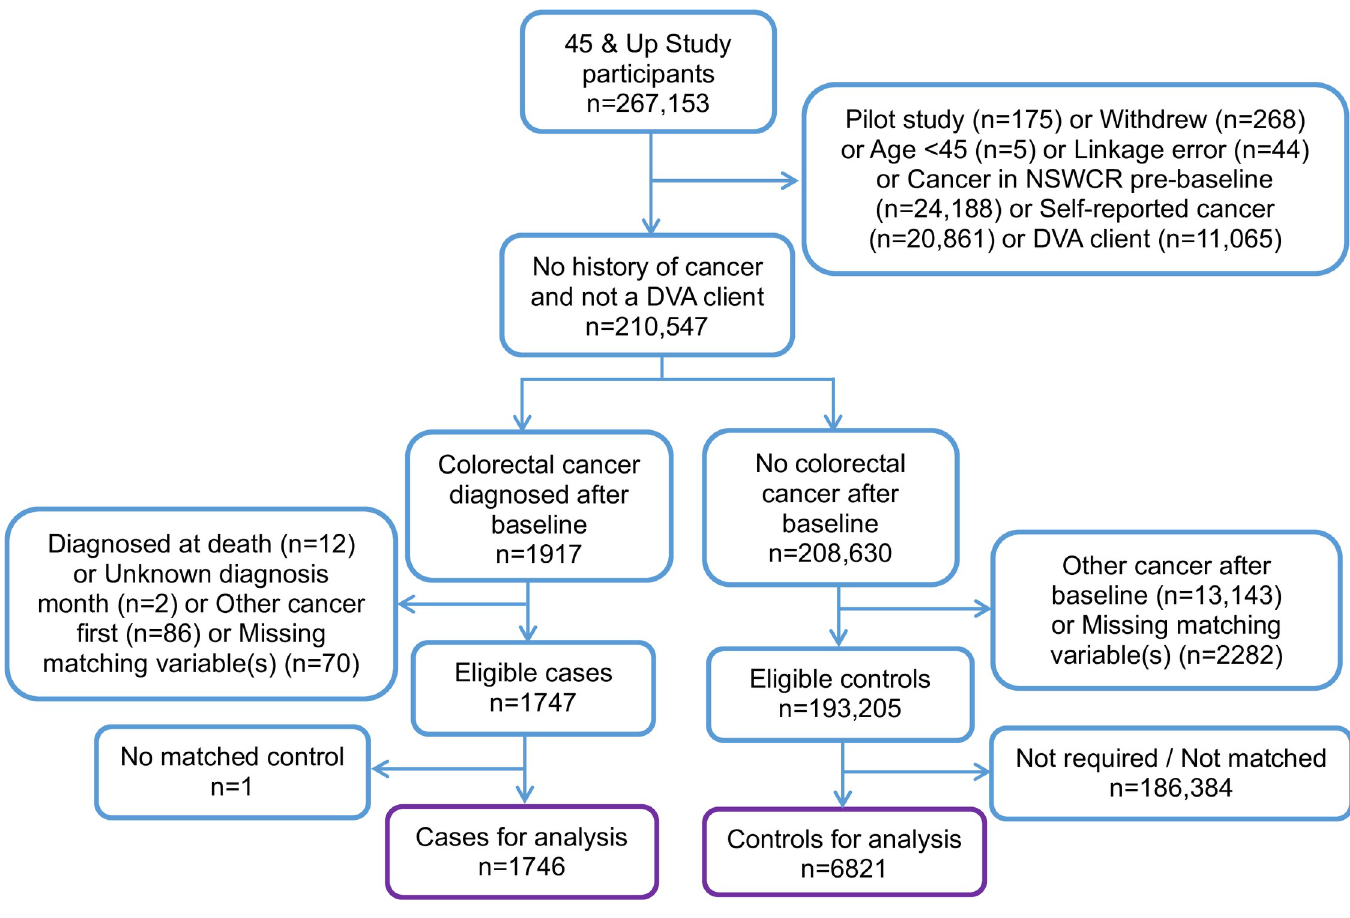
Fig 2. Cohort selection flow